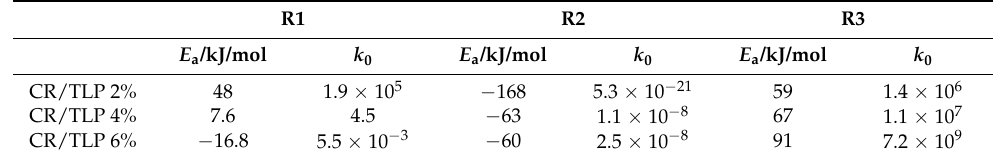
Table 4. Activation energy, E a , and pre-exponential factor k 0 values calculated from isothermal DSC analysis, for Reaction 1 (R1), Reaction 2 (R2) and Reaction 3 (R3).